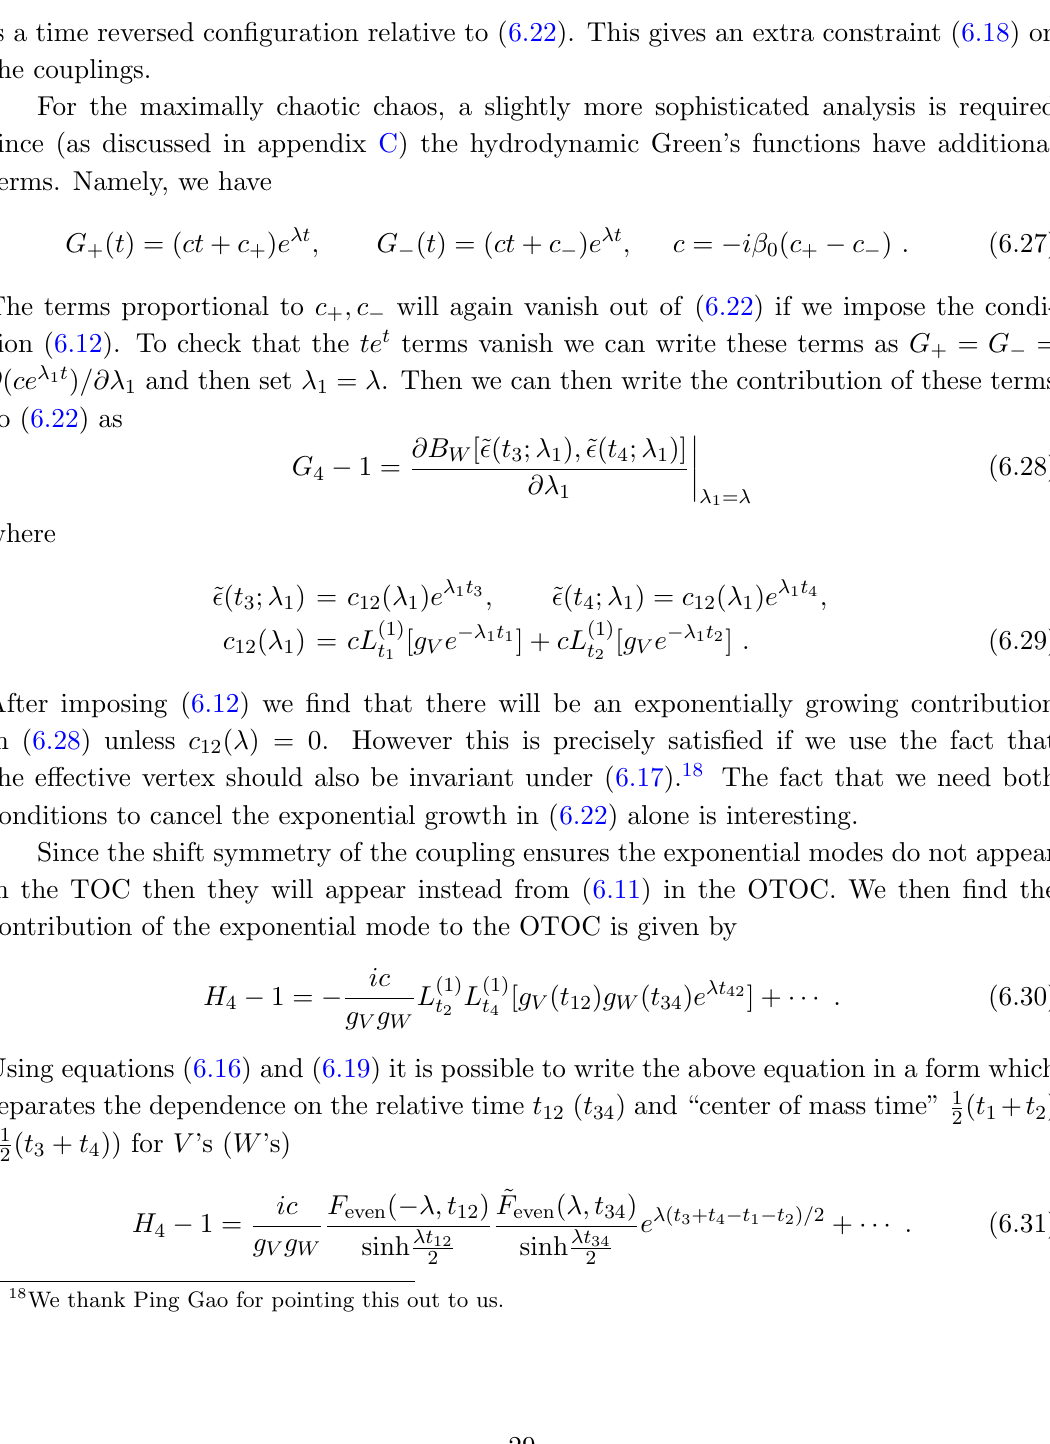
4 can be reduced to a four point function on a time reversed CTP